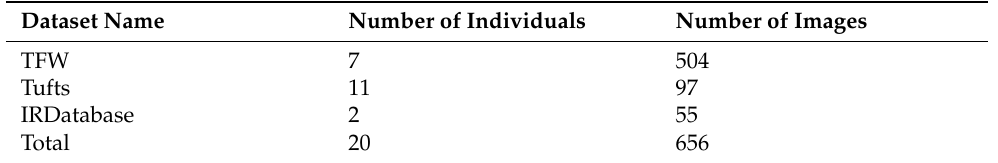
Table 1. Elderly dataset sources’ distribution.